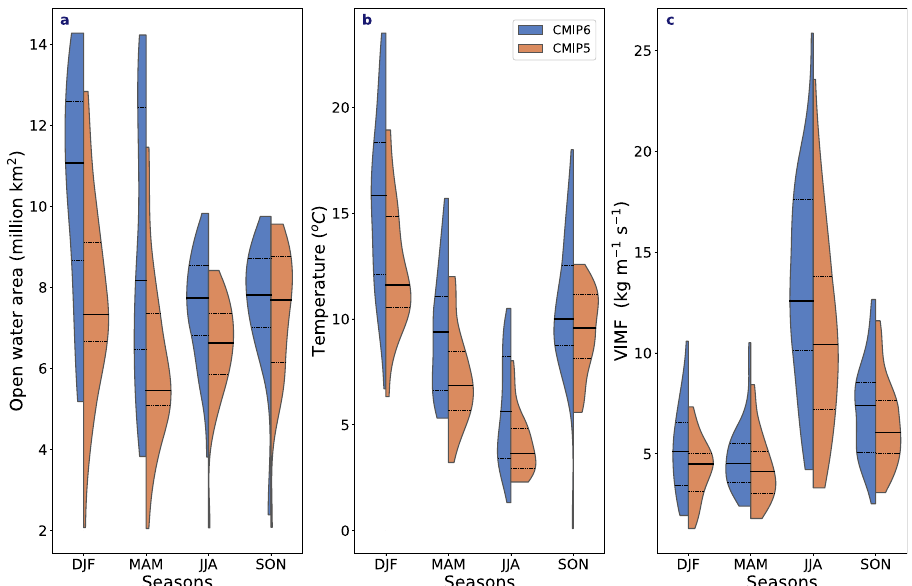
Fig. 6 End-of-century changes in sea-ice concentration, temperature and vertically integrated moisture fl ux. The end-of-century (2090 – 2100) changes relative to the start of the century (2005 – 2014) in all seasons in a open water area (million squared km), b temperature (°C) and c vertically integrated moisture fl ux (VIMF) at 70°N (kg m − 1 s − 1 ) for CMIP6 (blue) and CMIP5 (orange), where the colours represent the kernel distribution of all models. The solid black lines represent the multi-model ensemble means for both experiments and the dashed black lines denote the 25th and 75th percentile in each experiment.